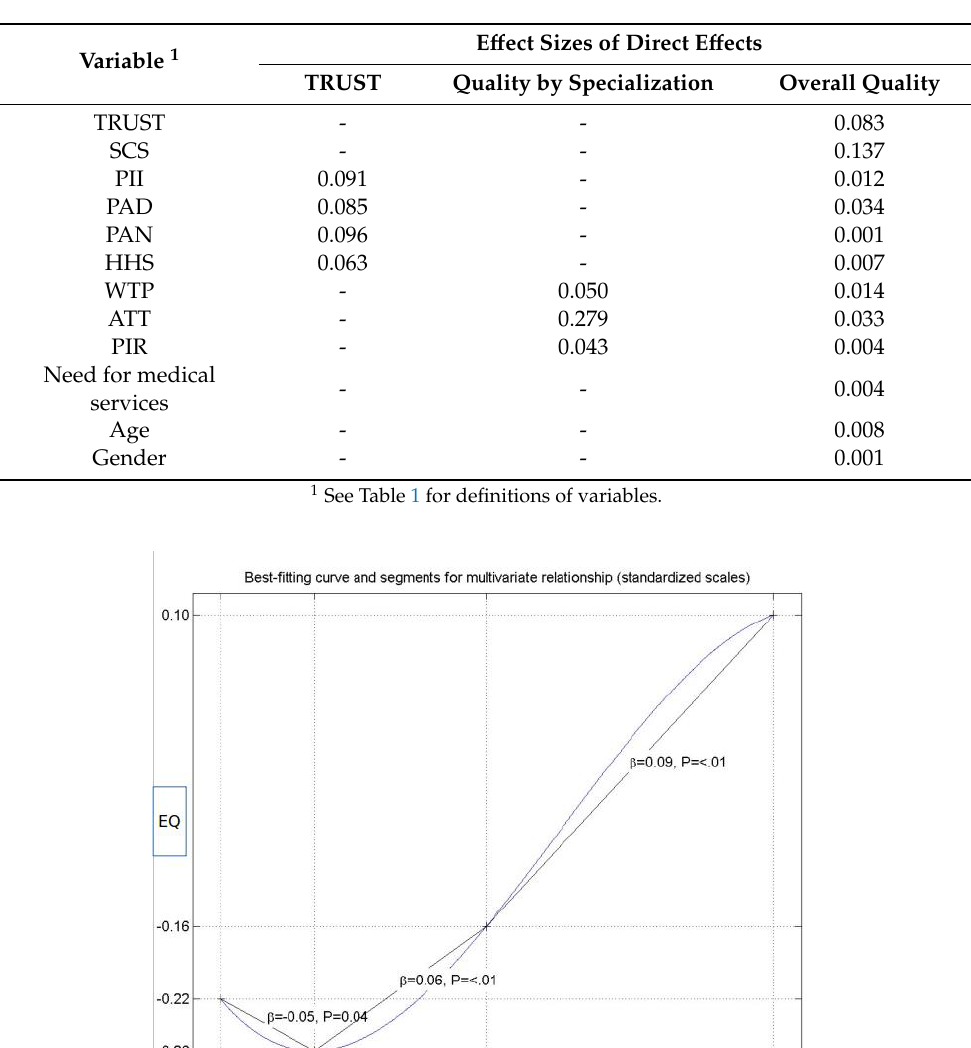
Figure 3. The non-linear relationship between the perception of overall quality and waiting time. 5. Discussion, Conclusions and Future Research Our study explored patients’ experience with the quality of the healthcare services in Romania. We considered two categories of predictors. One category was related to human capital, expressed as ATT, WTP, and PIR. The other category was related to social capital and was expressed as the PII